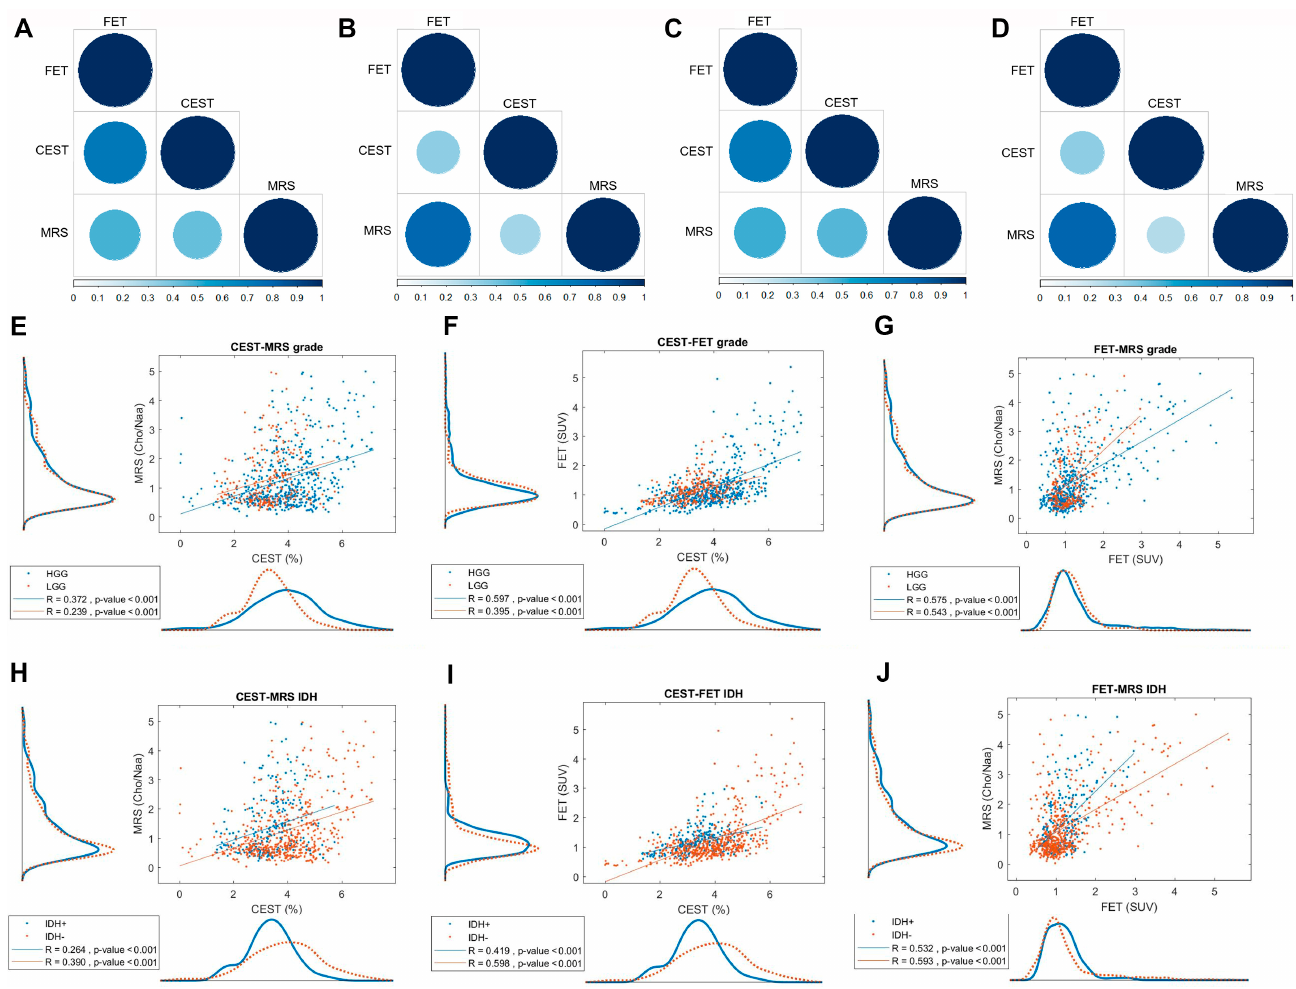
Figure 3. Correlations between APT-CEST, MRS and FET-PET according to tumor grade and IDH status. Patient − wise correlation plots depicting in high-grade glioma ( A ), low grade glioma ( B ), IDH wildtype group ( C ) and IDH mutant group ( D ). The size and color depth of the plots are proportional to the correlation, and correlation index from 0 to 1 was shown below; ( E − G ) Voxel − wise correlations according to tumor grade, CEST and MRS ( E ), CEST and FET PET( F ) and FET and MRS ( G ). ( H − J ) Voxel − wise correlations according to the IDH status, CEST and MRS ( H ), CEST and FET PET( I ) and FET and MRS ( J